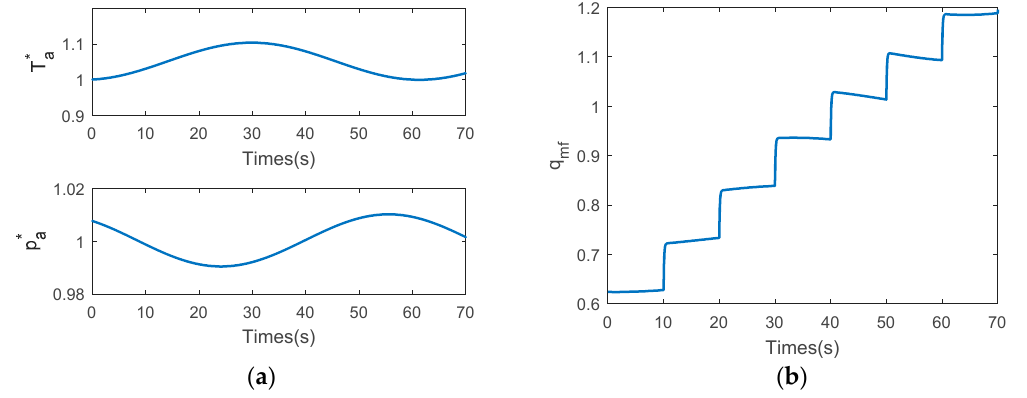
Figure 9. ( a ) Signal of EIC; ( b ) command signal of fuel flow.